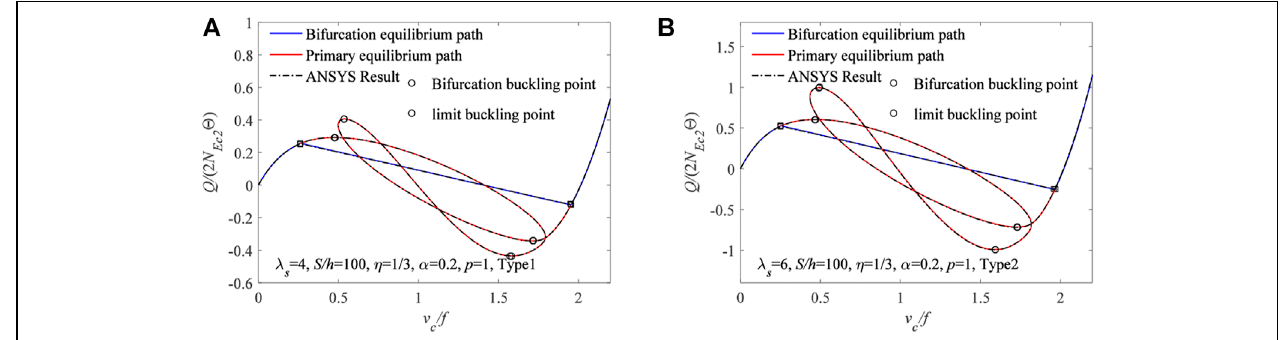
FIGURE 15 | ANSYS result and theoretical result of bifurcated instability load for pin-ended FGM arches having different types of cross-section: (A) Type 1. (B) Type